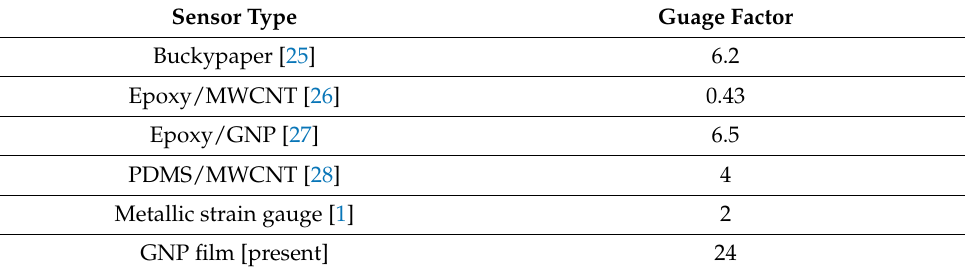
Figure 10. Conductive networks change of the hybrid nanomaterial film under stretching.